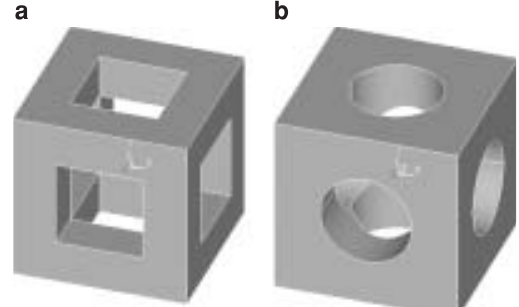
Figure 5 Unit cell scaffold with (a) open square pore and (b) open circular